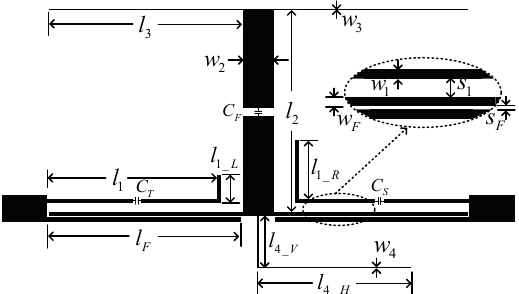
Figure 7. Layout of the fabricated filter ( l 1 = 12.2 mm, l 1_ L = 2.05 mm, l 1_ R = 4.35 mm, w 1 = 0.3 mm, s 1 = 0.5 mm, l F = 13.6 mm, w F = 0.3 mm, s F = 0.1 mm, l 2 = 13.75 mm, w 2 = 2.4 mm, l 3 = 13.4 mm, w 3 = 0.1 mm, l 4_ V = 3.6 mm, l 4_ H = 10.8 mm, w 4 = 0.1 mm).